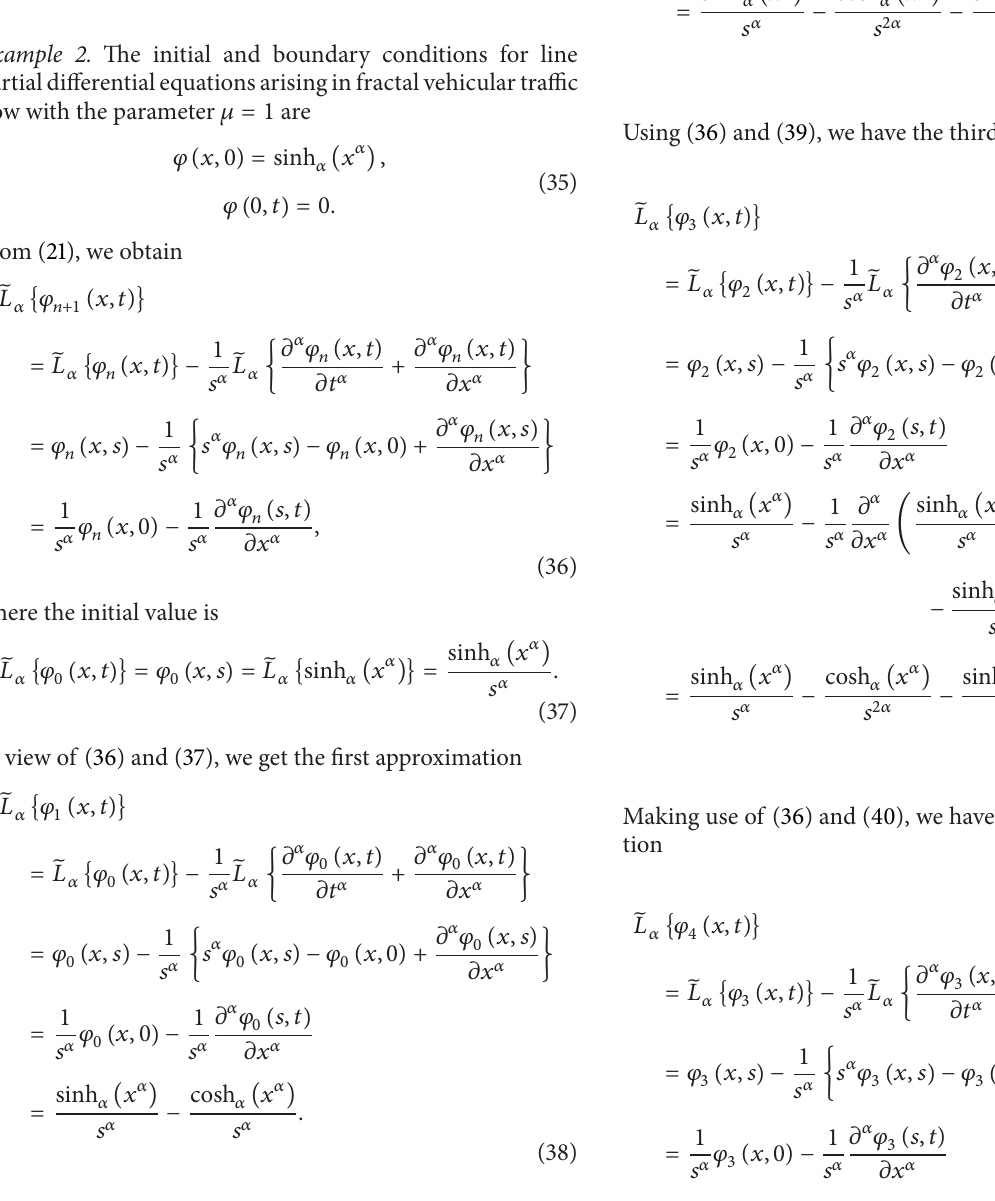
Figure 1: The graph of (1) with the parameters 𝛼 = ln 2/ ln 3 and 𝜇 = 2 .